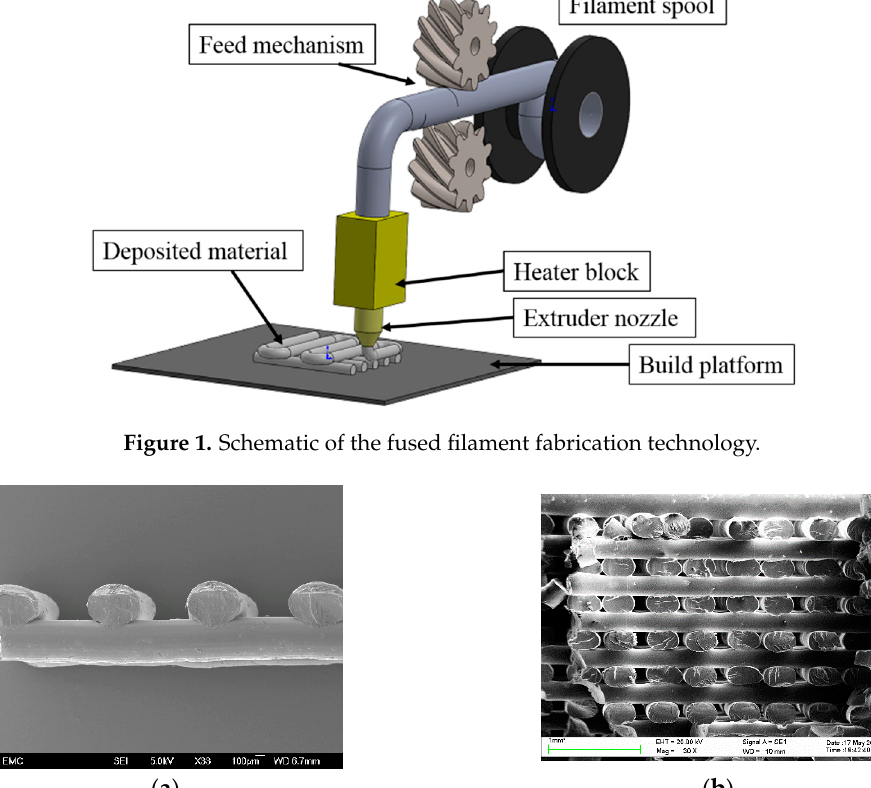
Figure 1. Schematic of the fused filament fabrication technology.